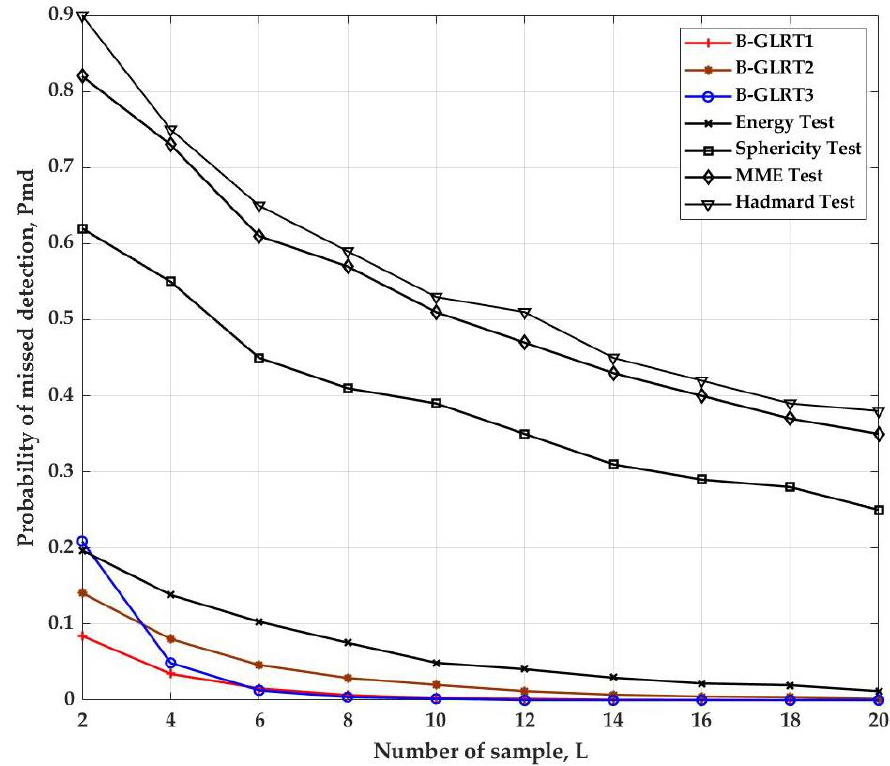
Figure 5. Probability of missed detection of the proposed approach versus L where a pfa = 5 × 10 − 1 , an average SNR = –3